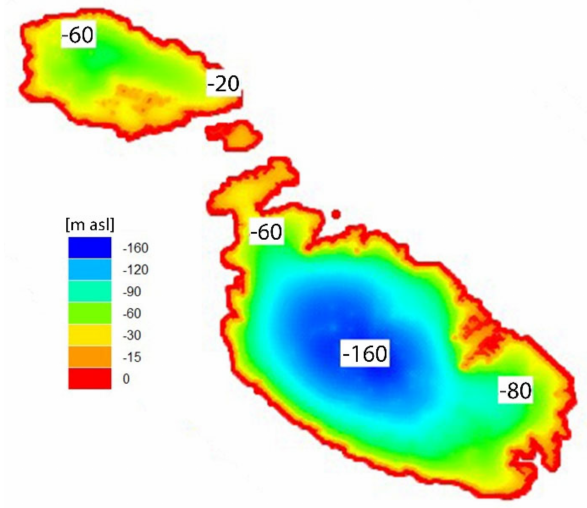
Figure 5. Spatial distribution of the saltwater–freshwater interface (m asl) simulated with SWI2.